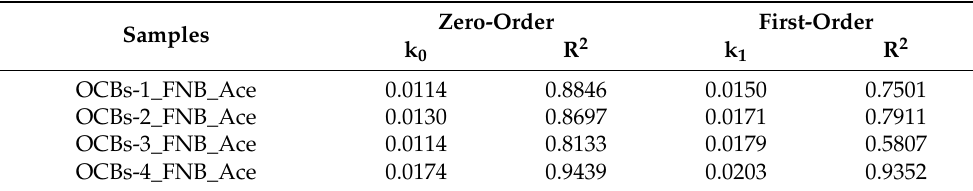
Table 2. Results of fitting the release data of FNB at pH = 1.2 with zero-order and first-order kinetic models.